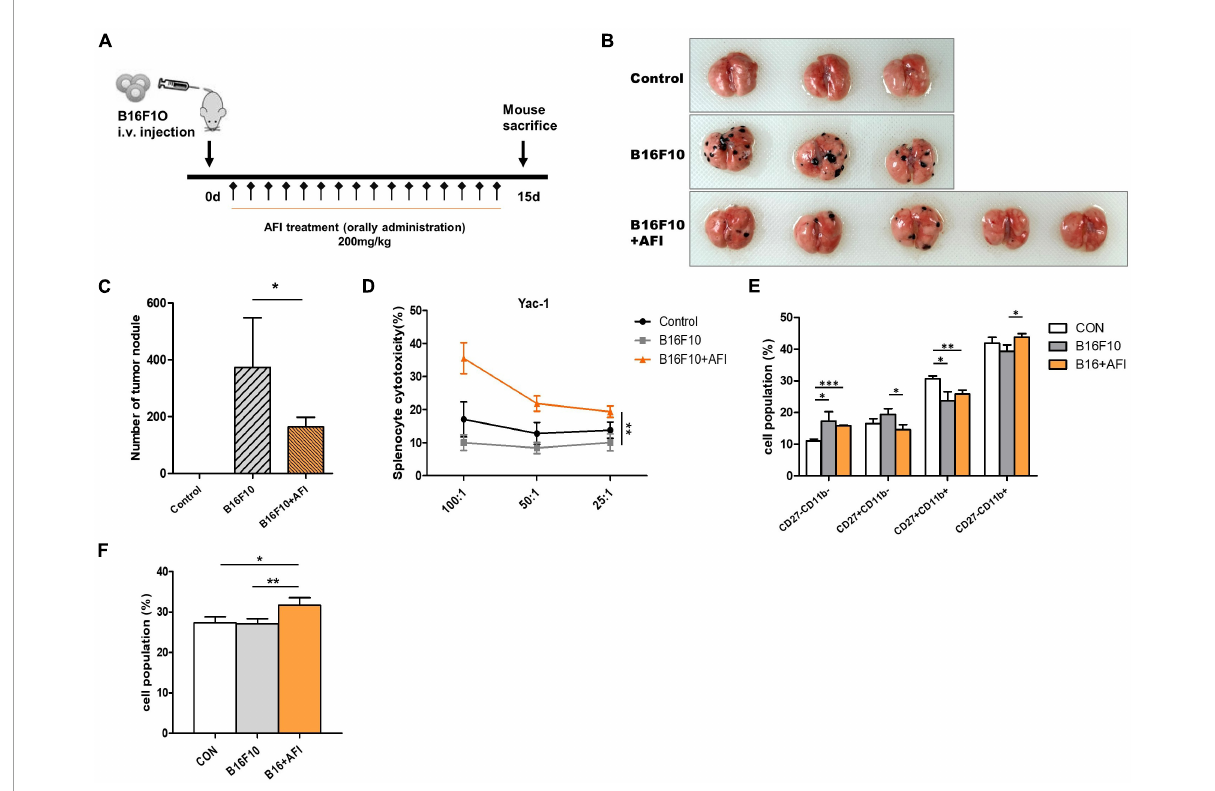
FIGURE6 Administration of Aurantii Fructus Immaturus (AFI) inhibits cancer metastasis in a mouse melanoma model. (A) Overall scheme to investigate the antitumor-enhancing effect of orally administered AFI in mice. Lung metastasis of wild-type mice (control) and those that were orally administered AFI was analyzed 15 days after intravenous injection of B16F10 cells. (B) Representative images of the lung (C) and the number of melanoma nodules on the surface of the lung. (D) Measurement of cytotoxicity of three groups of splenocytes against YAC-1 cells. (E) Four subsets of natural killer (NK) cells using CD27 and CD11b markers (F) and IFN- γ positive NK cells were analyzed by flow cytometry in mouse splenocytes after B16F10 injection and AFI dosing periods * p < 0.05, ** p < 0.01 and *** p <